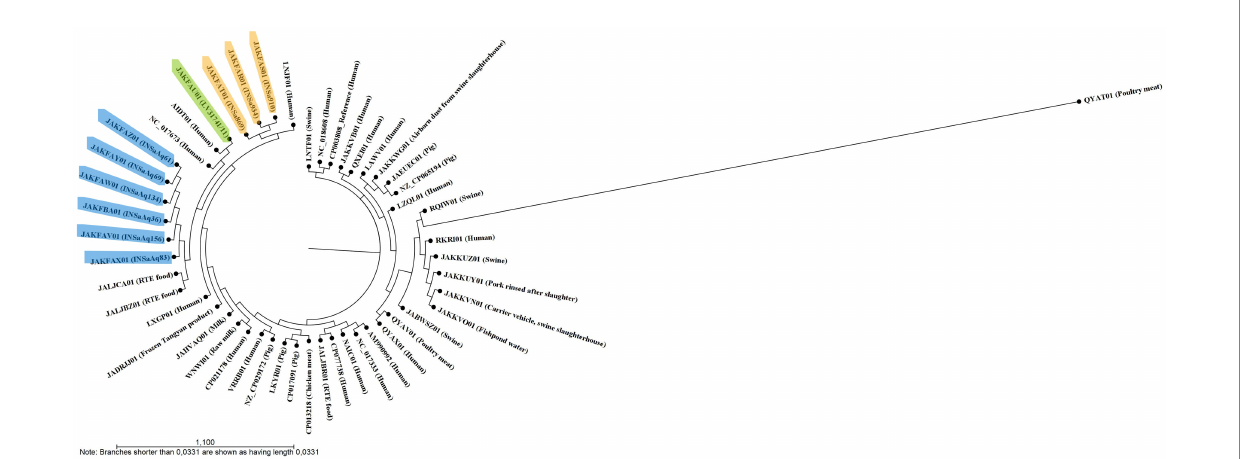
FIGURE 1 Single nucleotide polymorphism (SNPs)-based tree, constructed with CSI Phylogeny 1.4 (Kaas et al., 2014), showing the relationship between 50 S. aureus ST398 (10 from our study and 40 from NCBI database; Supplementary Table S1). Strains from this study are highlighted in different colors according to the origin of the samples (humans in orange, dolphin from a zoo in green and gilthead seabream from aquaculture in blue). This analysis divided the 10 S. aureus ST398 from this study into three distinct clades: one encompassing all strains from human origin that were more closely related to LNJF01 strain also from human origin; the second with the dolphin’ strain and two animal-independent MSSA isolated in humans (AIDT01 and NC_017673); and the third with strains from aquaculture that cluster together with two strains isolated in Russia from ready to eat (RTE) food (JALJCA01 and